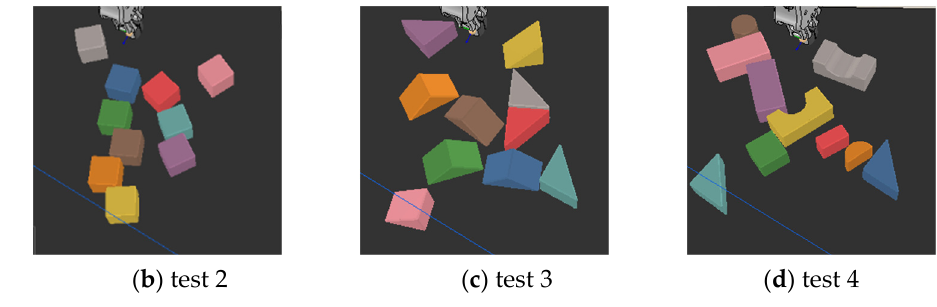
Figure 8. Four different test cases.